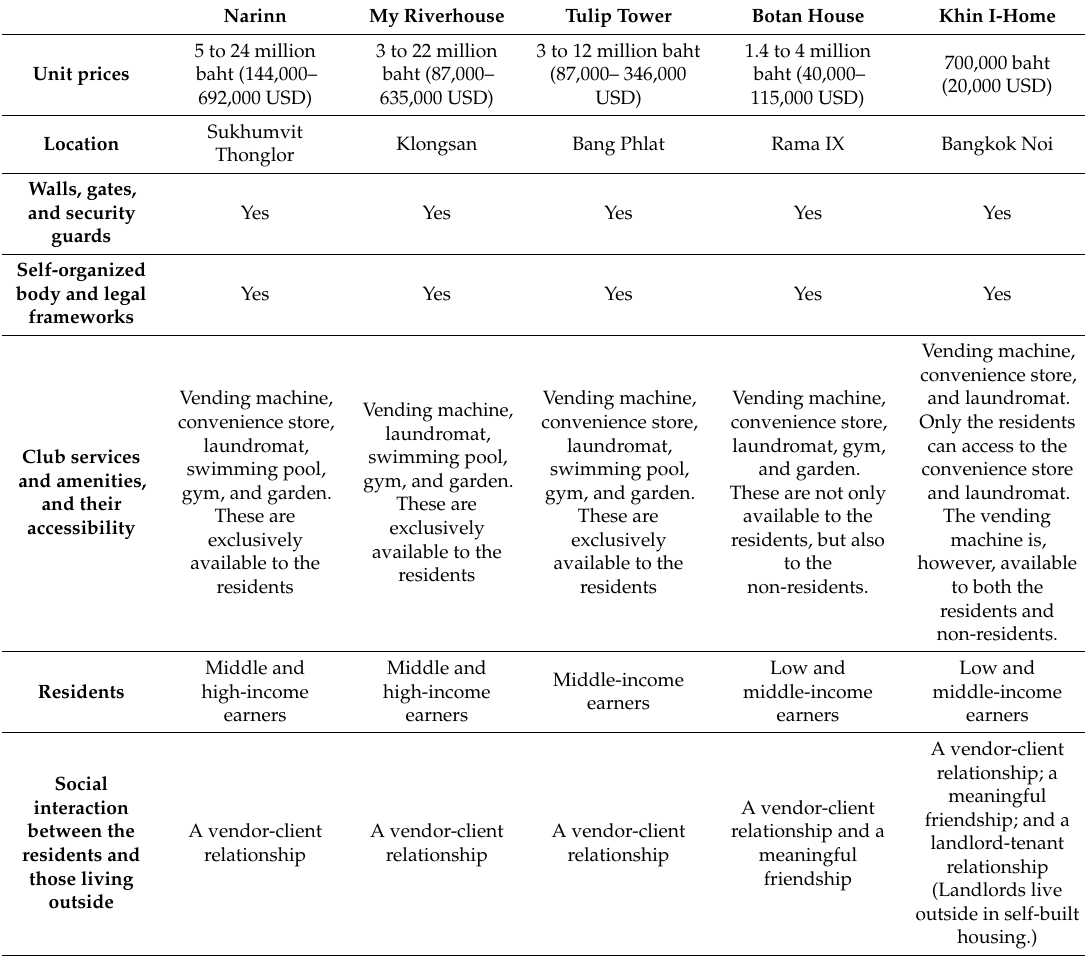
Table 1. Summary of key findings from the study of five high-rise housing estates in the Bangkok Metropolitan